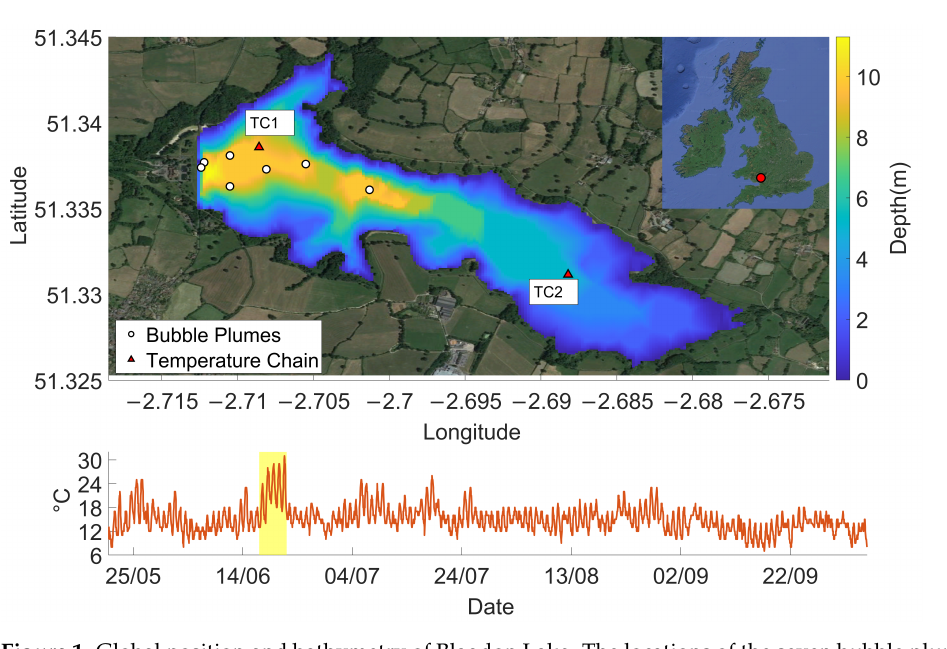
Figure 1. Global position and bathymetry of Blagdon Lake. The locations of the seven bubble plumes used to mix the reservoir and the two temperature chains deployed for this study are marked (white circles and red triangles, respectively; top ). A time series of 2017 air temperature data is shown, including the June 2017 heatwave which is highlighted in yellow ( bottom